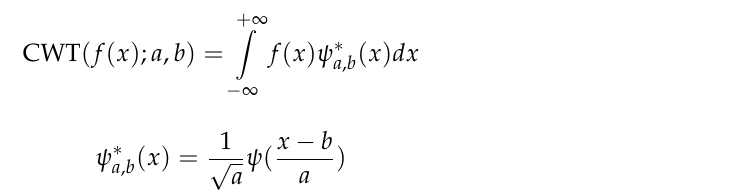
N f 1 f 2 Figure 2. Two-terminal alternating current (AC) transmission system. According to the traveling-wave theory [10], when a fault occurs on the transmission line, it is equivalent to superimposing an additional voltage source at the fault point. Under the effect of the additional source, traveling waves are generated and propagate along the line from the fault point to both terminals. Figure 3 shows the superimposed circuits of the internal fault f 1 and the external fault f 2 . The red solid arrows are the polarities of FACTWs while voltage of the additional source is negative, and the blue dotted arrows are the polarities of FACTWs while voltage of the additional source is positive. In Figure 3, assume that the postfault voltage on the fault point is V F = U m sin ( wt + θ ), the voltage of the additional source will be − V F , which varies with the change of the fault inception angle. If the fault inception angle is in the range of 0° to 180°, the voltage of the additional source will be negative, otherwise it will be positive. f 1 + -V F - M